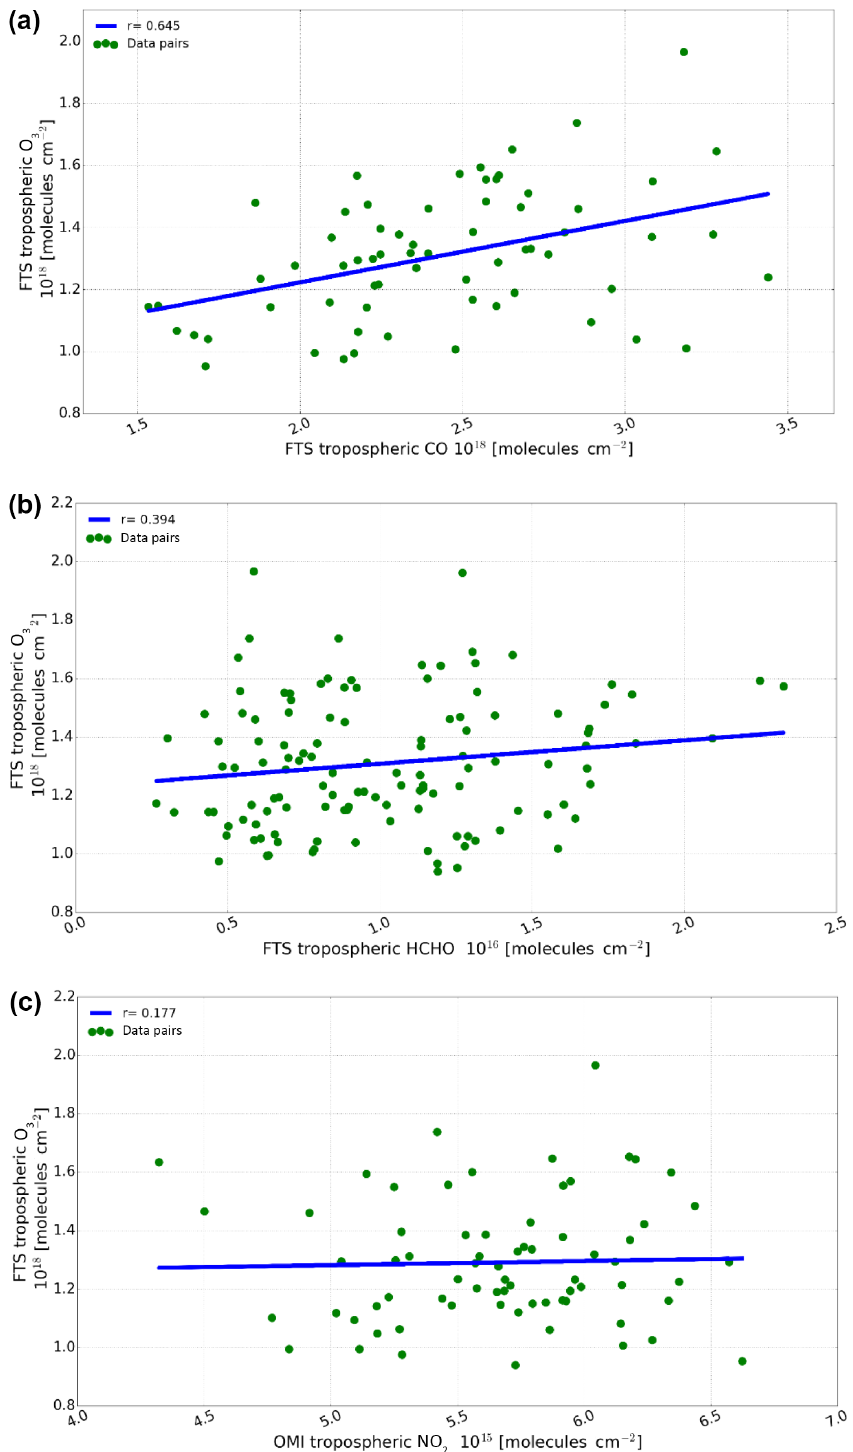
Figure 6. Correlation plot between the FTS tropospheric O 3 column and coincident tropospheric CO (a) , HCHO (b) , and NO 2 (c) columns. The CO and HCHO data are retrieved from FTS observations, and the NO 2 data were deduced from the OMI product.